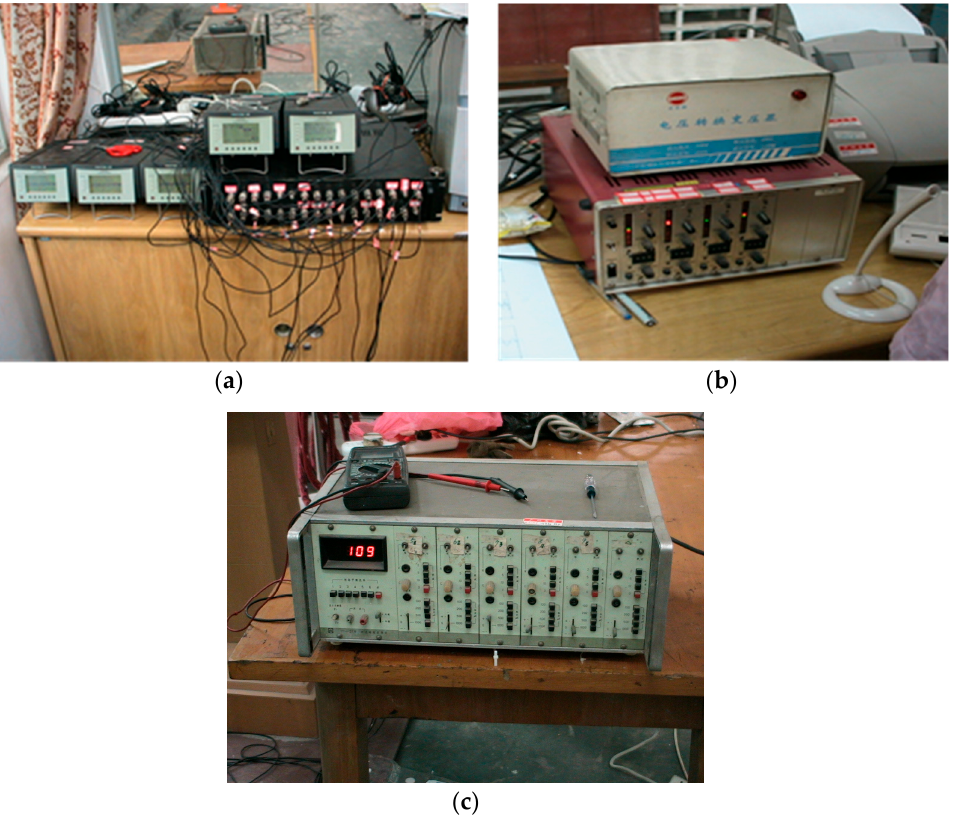
Figure 9. Conversion instruments.